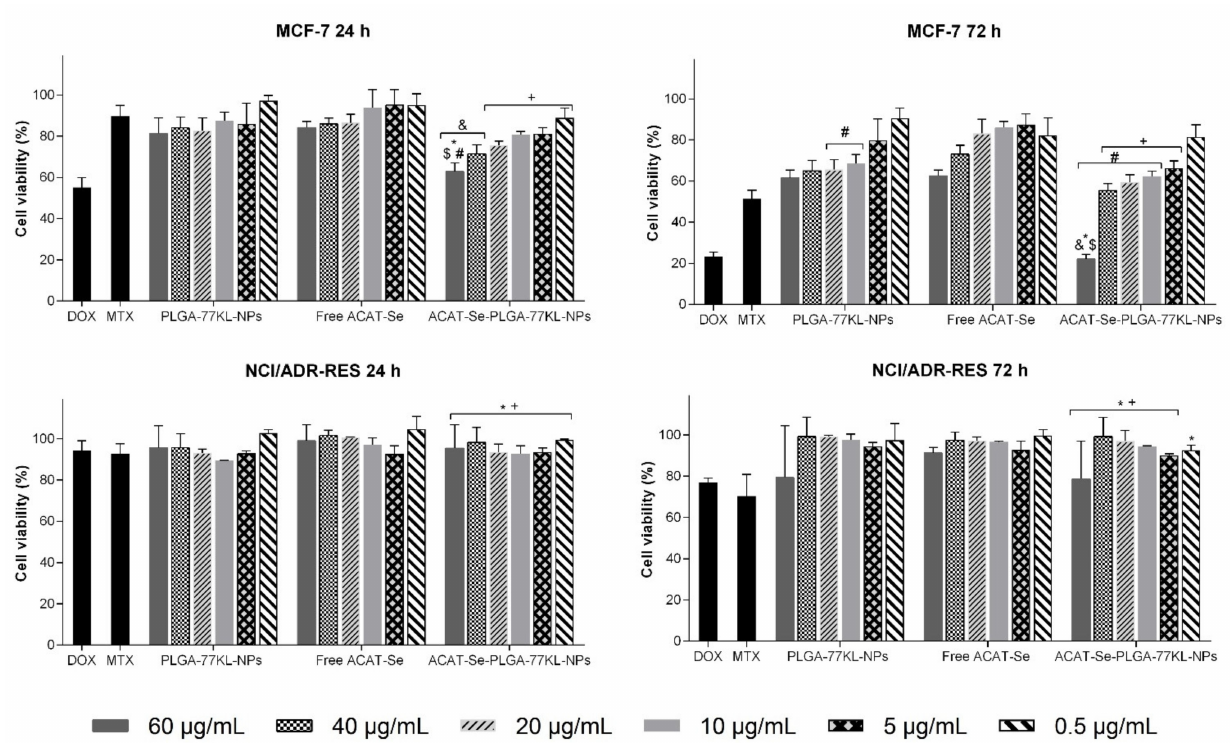
Figure 6. In vitro cell viability by MTT assay in MCF-7 and NCI/ADR-RES cell lines after 24 and 72 h of treatment. antitumor drugs MTX (50 µ g/mL) and DOX (10 µ g/mL) were used as positive controls. Data are expressed as mean of three independent experiments ± SE. Statistical analyses were performed using ANOVA followed by Student–Newman–Keuls multiple comparison